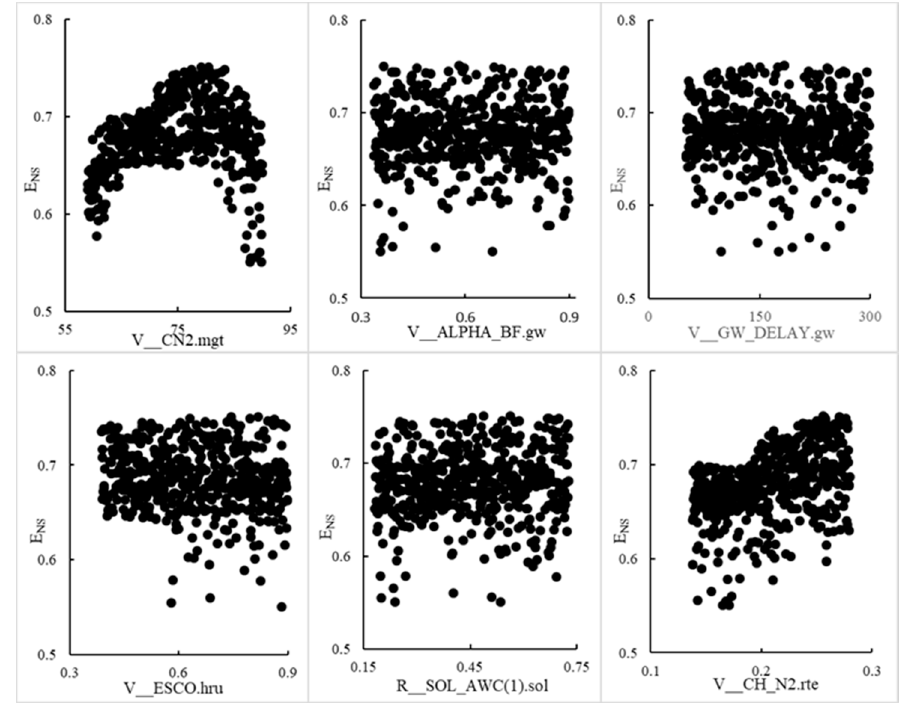
Figure 6. Parameter combination and distribution of Nash–Sutcliffe efficiency coefficient of Xinxue River basin based on SUFI-2.